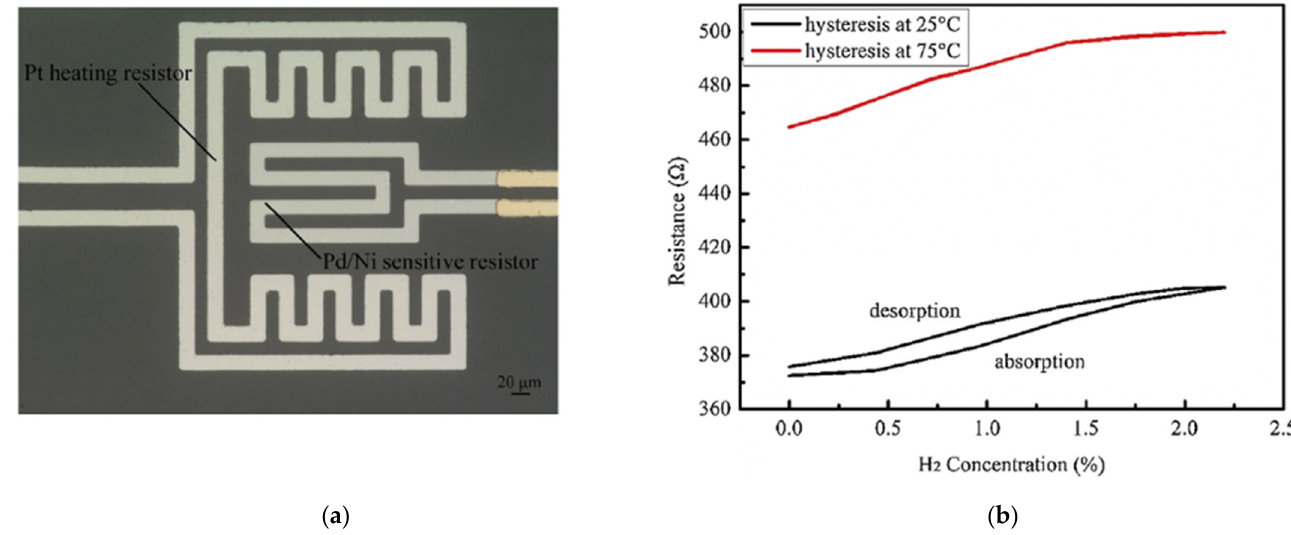
Figure 4. ( a ) The optical microscope image of the Pd/Ni sensor and ( b ) the hysteresis of hydrogen absorption and desorption at 25 °C and 75 °C [37]. Copyright (2019), with permission from Elsevier.